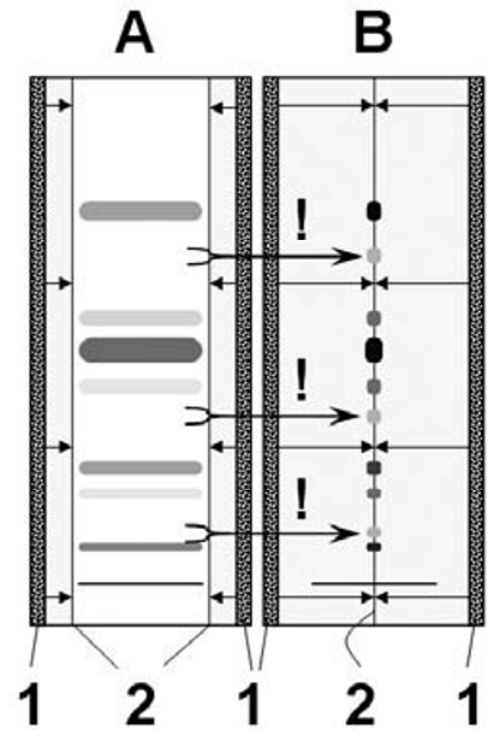
Figure 5. Schematic diagram of bilateral band compression. A, initial period of the process; B, final stage of the compression. 1, foam to transfer the mobile phase for band compression; 2, mobile phase fronts. Arrows represent eluent movement for band compression; the arrow with curly brackets at the end indicates the effect on minor component